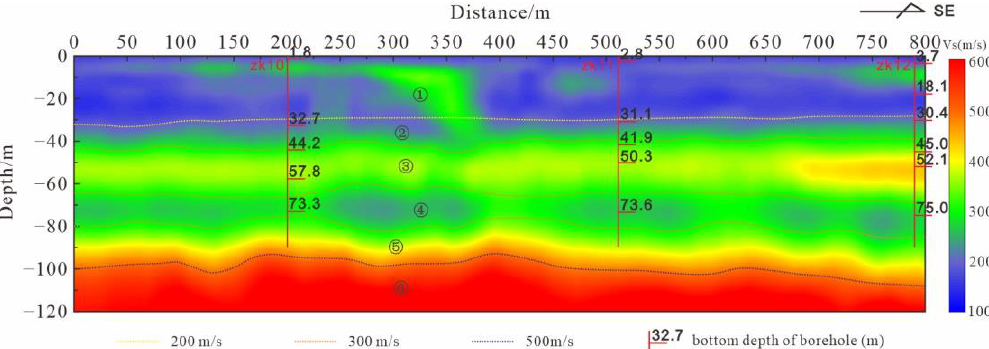
Figure 9. Microtremor inversion result of the Shamao line in area II.